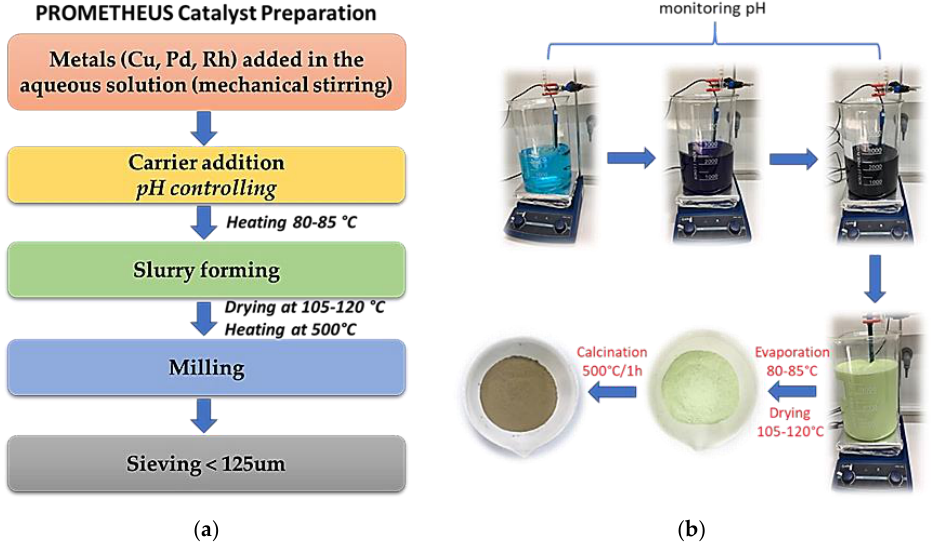
Figure 4. Preparation of Prometheus catalyst: ( a ) catalyst preparation flow chart; ( b ) schematic description.